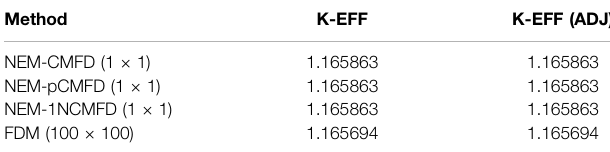
TABLE 4 | Calculated multiplication factors for the KWU 2D